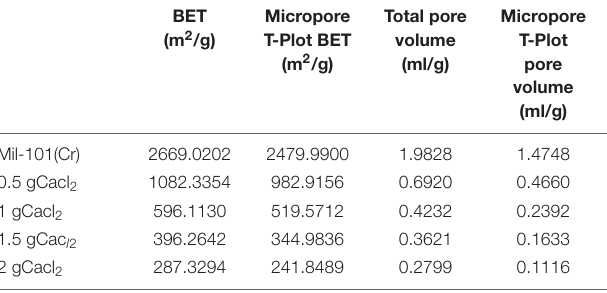
TABLE 2 | Pore performance data (BET) of calcium chloride mil-101 (Cr) composite.